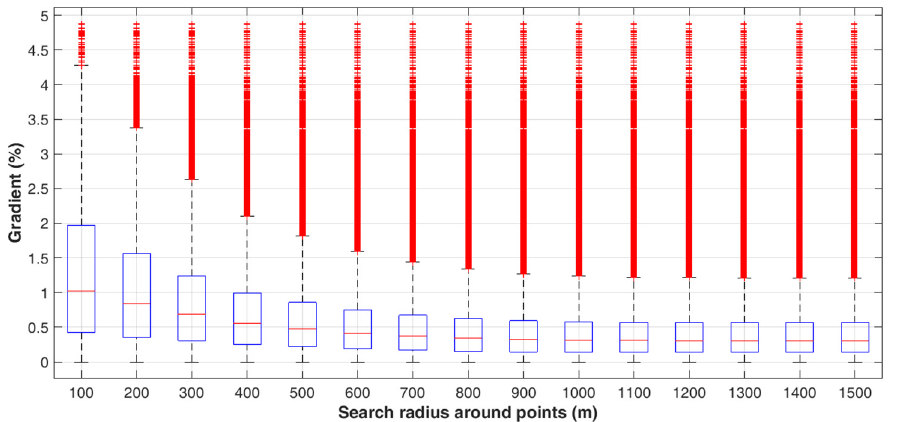
Figure 16. Slope distribution of the final surface: experiment R1, year 40.